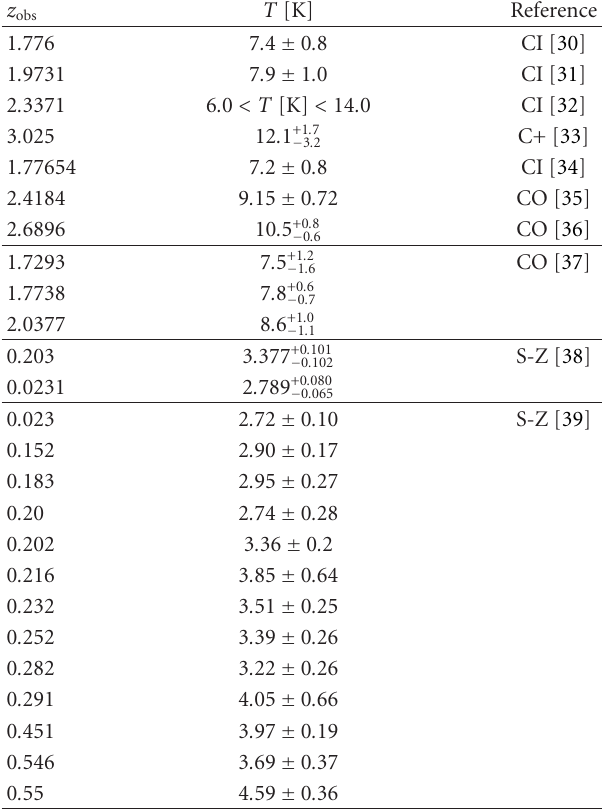
Table 1: Observational temperatures obtained from molecular excitation levels and S-Z e ff